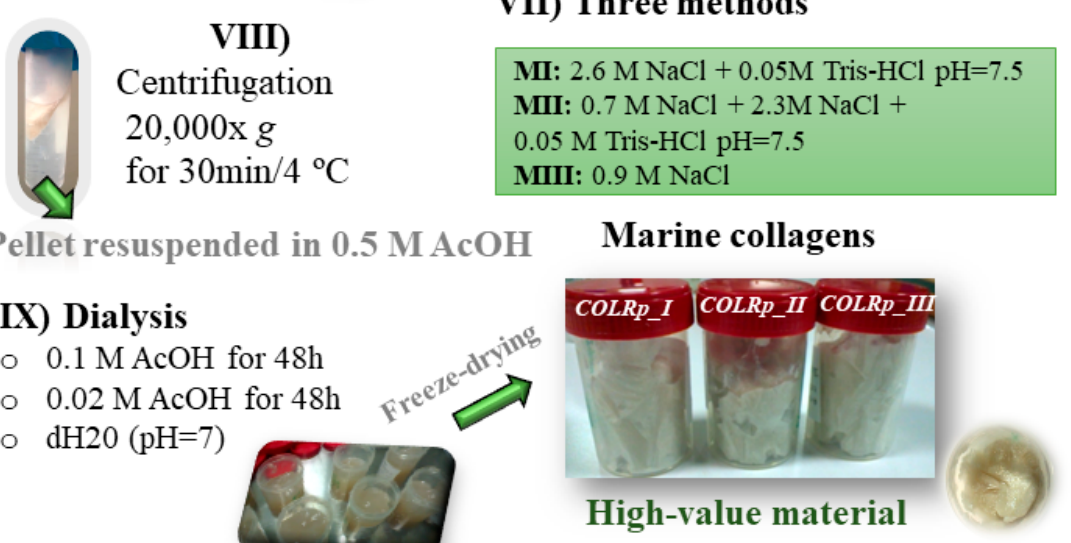
Figure 1. Schematic representation of extraction of marine collagens using the skin byproducts from R. hippoglossoides fish as valuable raw material.